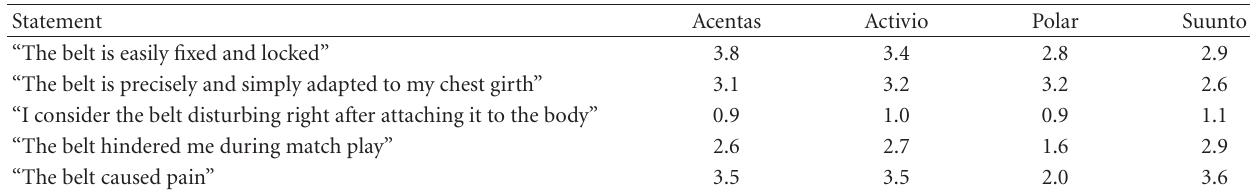
Table 3: Score from the chest-belt questionnaire. (0 = “totally agree”; 5 = “absolutely